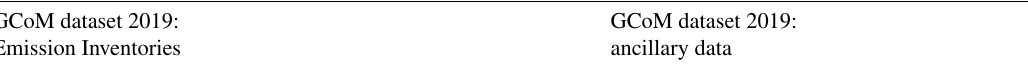
Table 1. Datasets and their